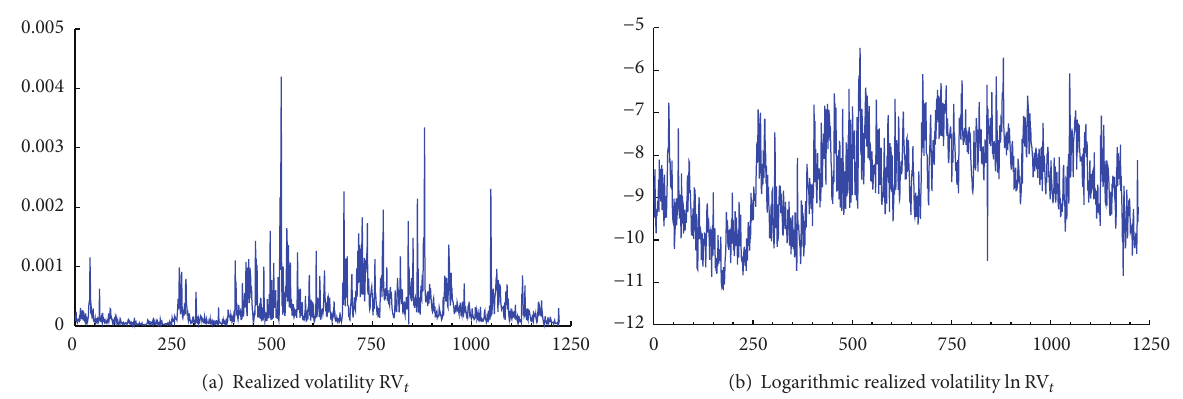
Figure 2: Time series plots of the CSI 300 index’s realized volatility and logarithmic realized volatility.